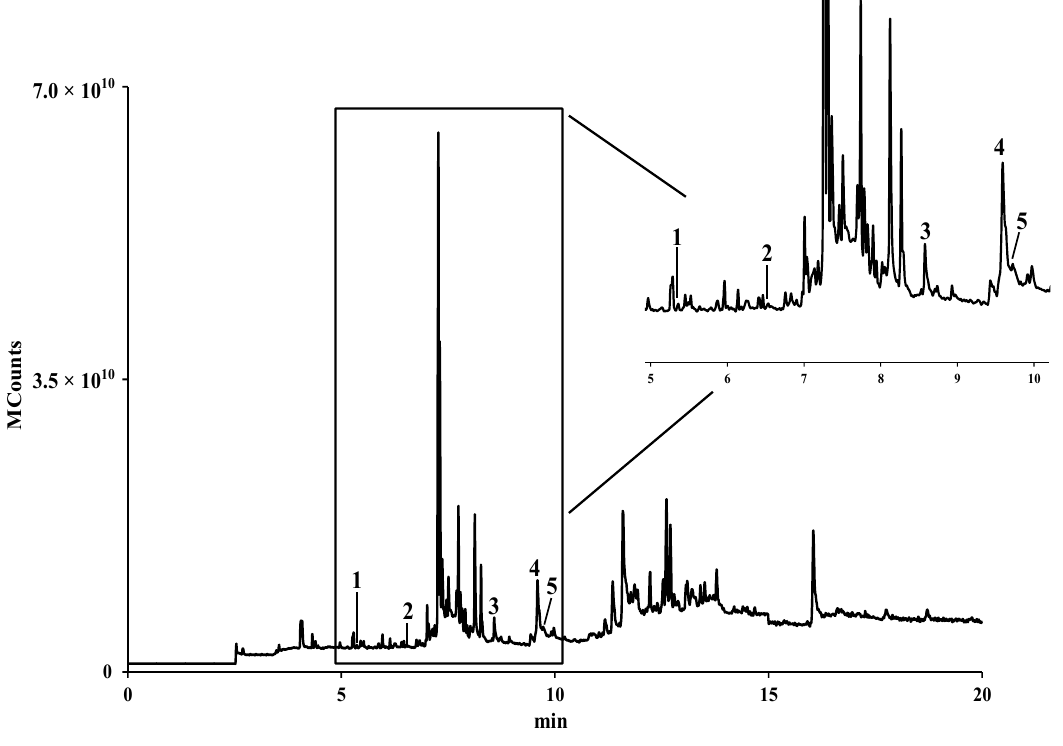
Figure 2. GC-IT/MS fatty acids profile of E. plantagineum hydromethanolic extract. Identity of compounds as in Table 2. All compounds correspond to their trimethylsilyl (TMS) derivatives.